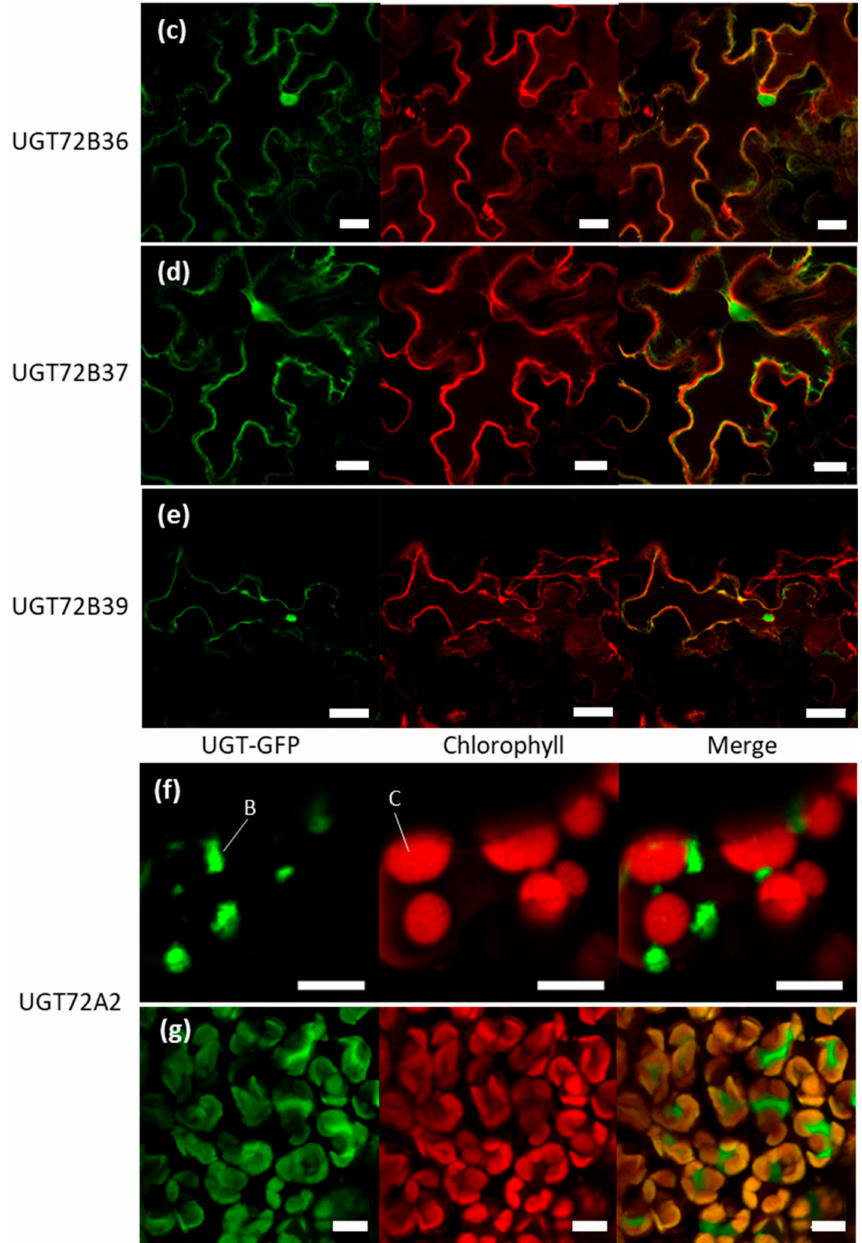
Figure 9. Subcellular localization of poplar UGT72 fused to GFP. ( a – f ) UGT72-GFP fusion proteins and 35S::AtWAK2-mCherry, as ER marker ( a – e ) in N . benthamiana leaf epidermal cells after agroinfiltration. UGT72A2-GFP ( f ) was localized in bodies associated to chloroplasts (red fluorescence). ( g ) Stable transgenic poplar line expressing the same 35S::UGT72A2-GFP construct. UGT72A2 was localized in in bodies associated with chloroplasts and possibly in chloroplasts. Images are representative of biological triplicates. B, bodies associated with chloroplast; C, chloroplast; ER, endoplasmic reticulum; N, nucleus. Scale = 20 µ m ( a ), 35 µ m ( b – d ), 70 µ m ( e ), 5 µ m ( f ), 10 µ m ( g